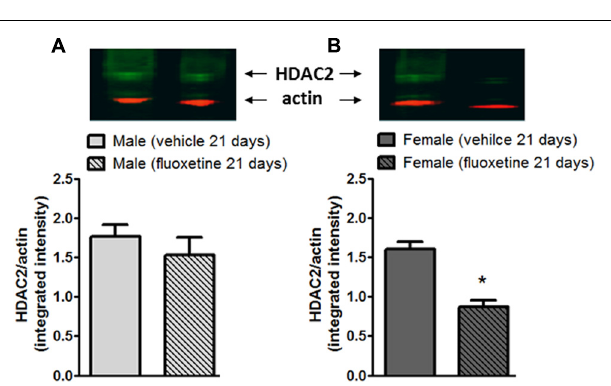
FIGURE 2 | Expression of HDAC2 in the L4-L5 DRGs of male and female mice after chronic administration with fluoxetine. Chronic administration with fluoxetine (10 mg/Kg, i.p. for 21 days) selectively decreased the expression of HDAC2 in DRGs from female mice (B) but not in male mice (A) . (Upper panels) Representative western blot analysis for HDAC2 in DRGs. (Lower panels) Densitometric analysis of HDAC2 bands normalized by actin. Data are the means ± SEM of five animals. ∗ p < 0.05 (Student’s t -test) versus values obtained in animals of the same sex treated with